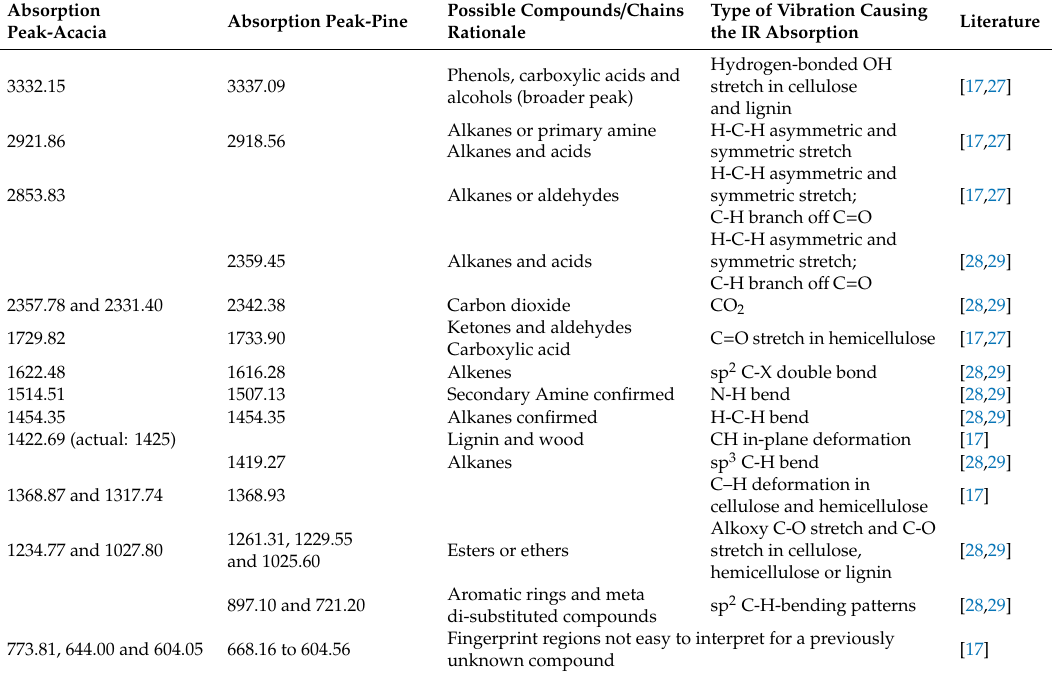
Figure 5. FTIR peaks for pine dust. Table 4. Compounds represented by the acacia and pine FTIR